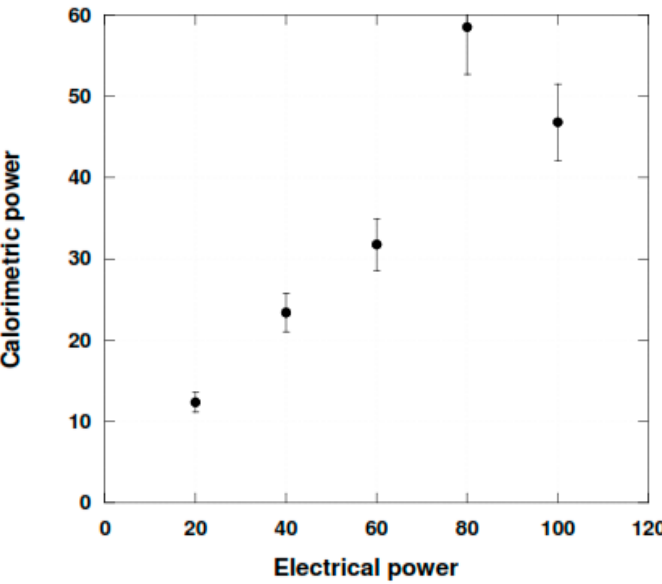
Figure 3. Ultrasonic energy (colorimetric method) absorbed in water with increasing electrical power input 352 kHz; 400 mL.